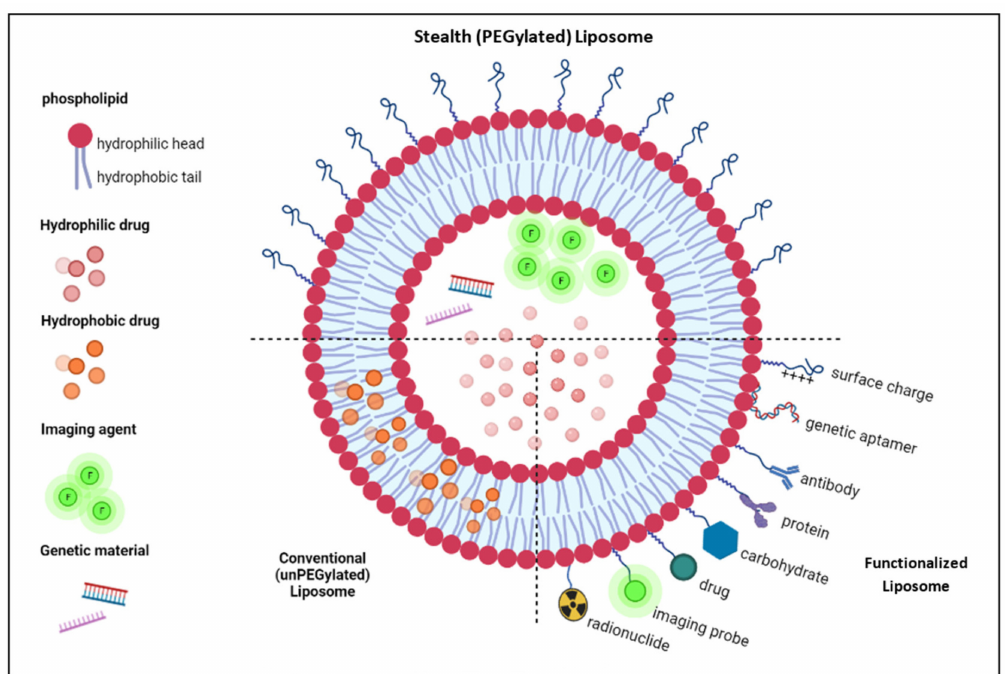
Figure 2. Possible loading, functionalization, and surface engineering schemes of liposomes.